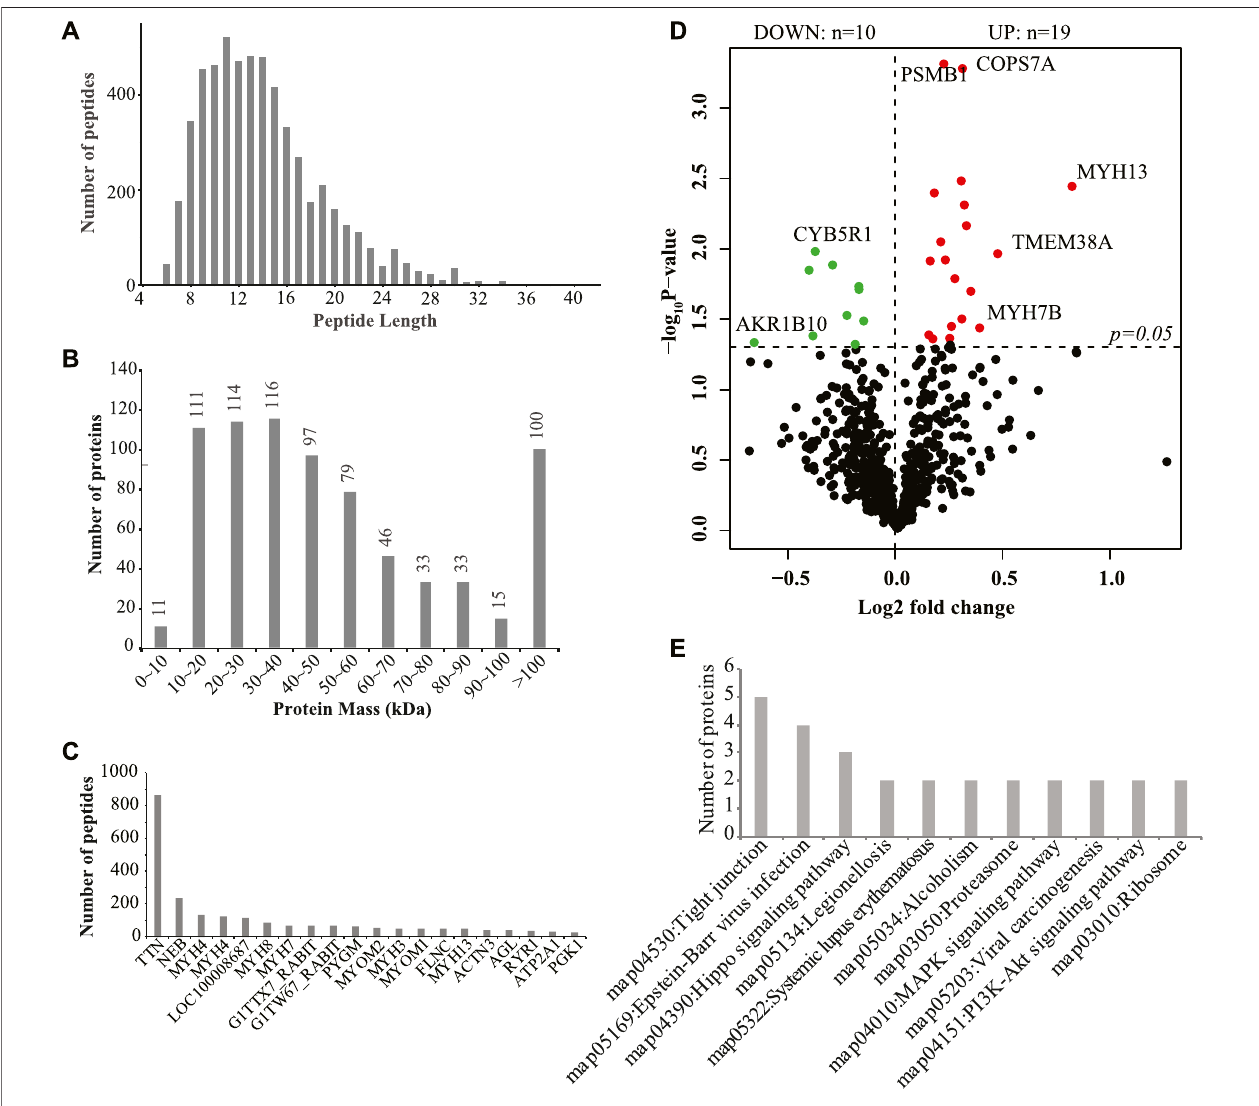
FIGURE 3 | iTRAQ proteomics identi fi ed differentially expressed proteins in the longissimus muscle tissues of SCWrabs and ZIKArabs. (A) Length distribution of peptides detected in the longissimus muscle tissues by iTRAQ. (B) Distribution of protein mass. (C) Top highly expressed proteins in the longissimus muscle tissue of rabbits. (D) Volcano plot of the differentially expressed proteins in the muscle tissues of SCWrabs and ZIKArabs. (E) KEGG pathway enrichment analysis for the differentially expressed proteins.